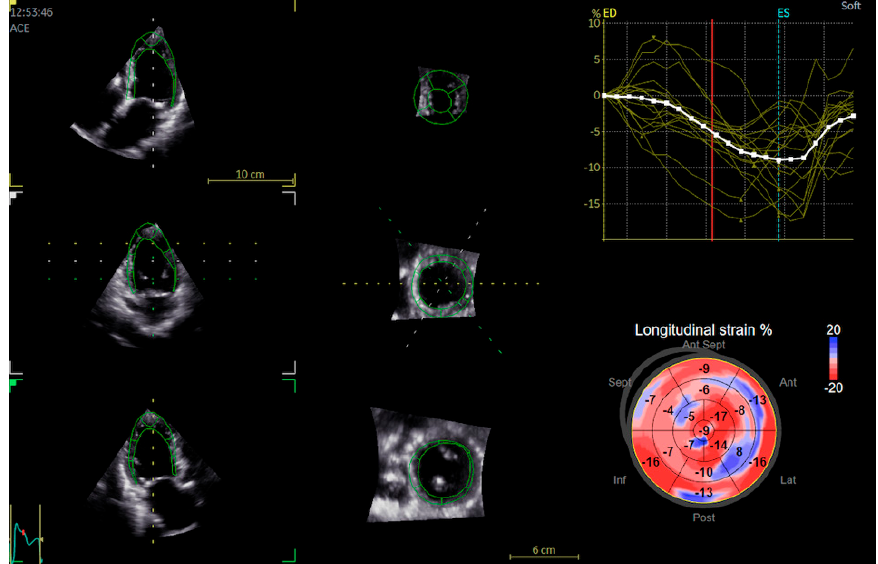
Figure 2. Automatic left ventricular quantification (AutoLVQ) plane after segmentation process with bull’s eye reconstruction of 3D global longitudinal strain. Red color and more negative number means better contractility as opposed to positive numbers and blue colour.